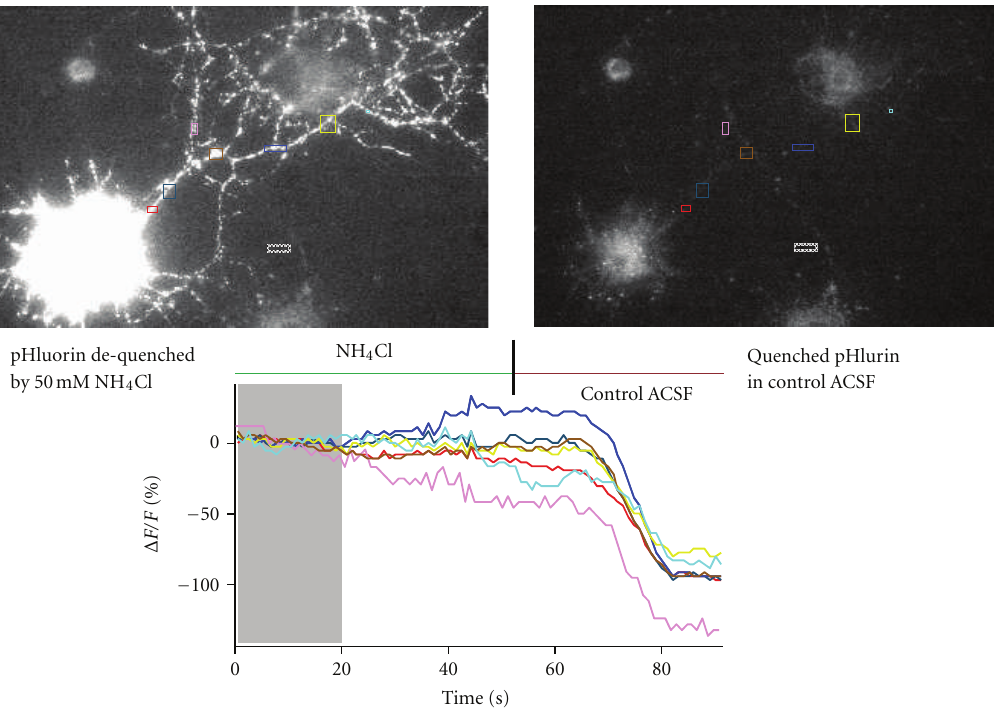
Figure 3: Left panel shows a BDNF-pH expressing hippocampal neuron in the presence of 50mM NH 4 Cl. Right panel shows the same cell 80sec after standard ACSF solution was applied. The graph shows the time course of the fractional change of BDNF-pH intensity (background-subtracted delta F/F 0 ) from pixels within the color-coded regions of interest (ROIs) shown in the panels above. The change from NH 4 Cl-containing ACSF to control bu ff er quenches BDNF-pH within acidic secretory granules. Time-lapse was performed in an inverted microscope with a Hg-lamp and a cooled CCD camera. Neurons were imaged with a 60x 1.45 NA oil-immersion objective, exposure times ranged from 50–100 ms, and images were taken at 1 frame per second